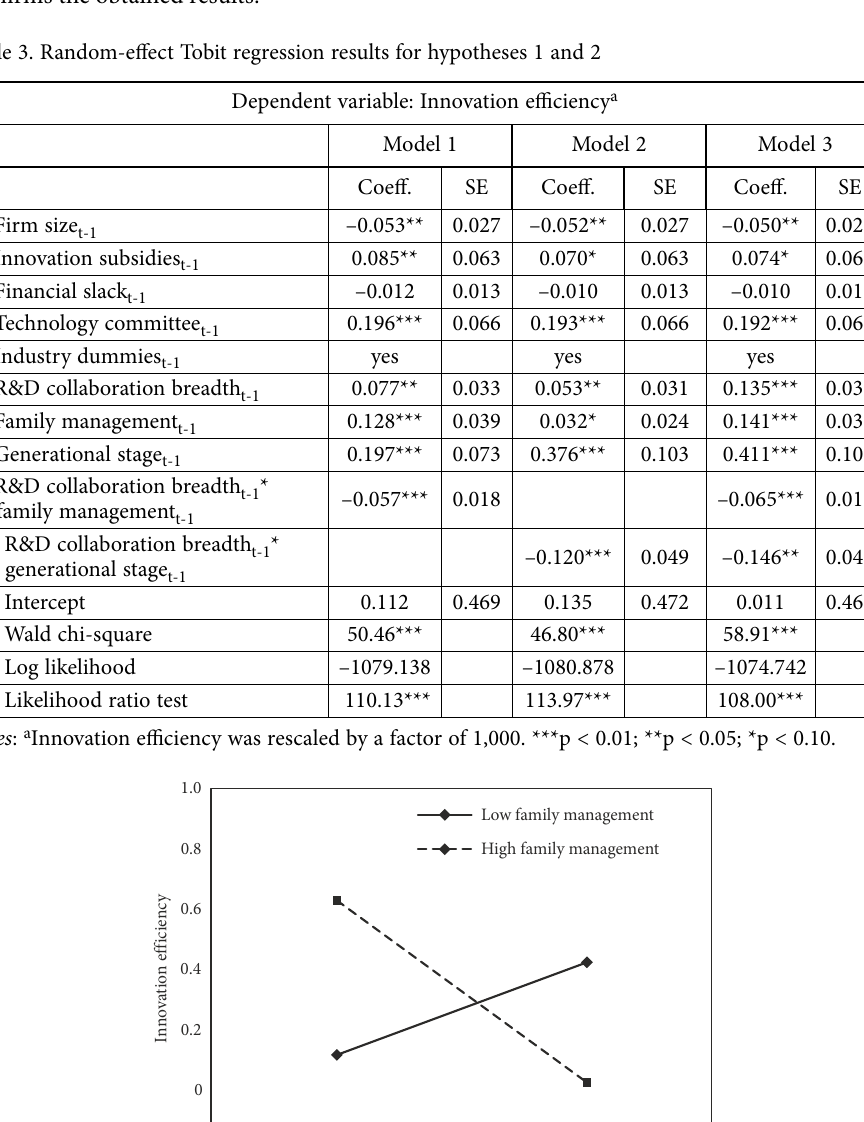
Figure 3. These results indicate that the relationship between R&D collaboration breadth and innovation efficiency is weaker for family firms in first generational stage. Thus, hypothesis 2 is strongly supported.